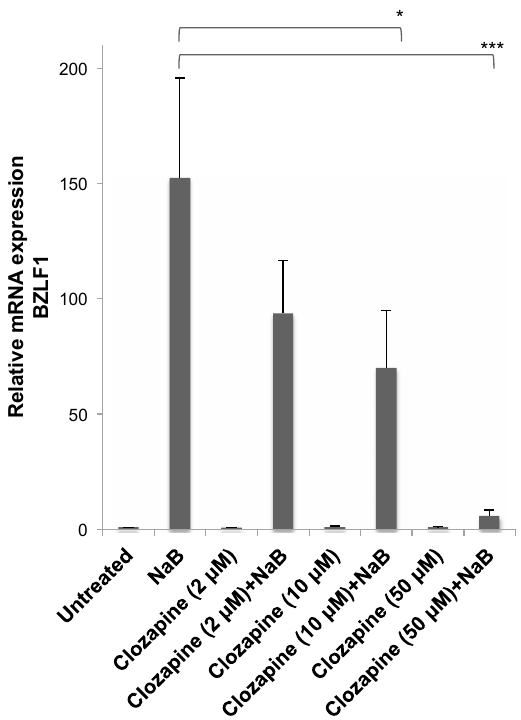
Figure 3. Inhibition of Epstein–Barr virus (EBV) lytic reactivation by clozapine was dose dependent. Clozapine (2, 10, and 50 µ M) was tested in the presence and absence of NaB (3 mM) for the e ff ects on BZLF1 expression in HH514-16 cells. Values are the average of seven biological replicates. There was no significant di ff erence between untreated cells and cells treated with only clozapine at any concentration. Di ff erences in BZLF1 expression comparing cells treated with butyrate in the absence and presence of clozapine are marked with * for p -value < 0.05 and *** for a p -value < 0.001. The concentrations of clozapine that inhibited EBV lytic reactivation, up to 50 µ M, did not limit cell growth or the percentage of dead cells when treated for 24 h (Figure 4). With 50 µ M clozapine, cells remained > 93% ± 4% viable ( n = 6) after 48 h and 88% ± 3% viable ( n = 3) after 72 h of treatment. Toxicity was observed within 24 h when the clozapine concentration reached 100 µ M. Cell toxicity with 100 µ M clozapine varied widely among experiments, but the average of 12 replicates resulted in ~40% cell death. When the clozapine concentration reached 200 µ M, nearly all of the cells were dead after 24 h in all